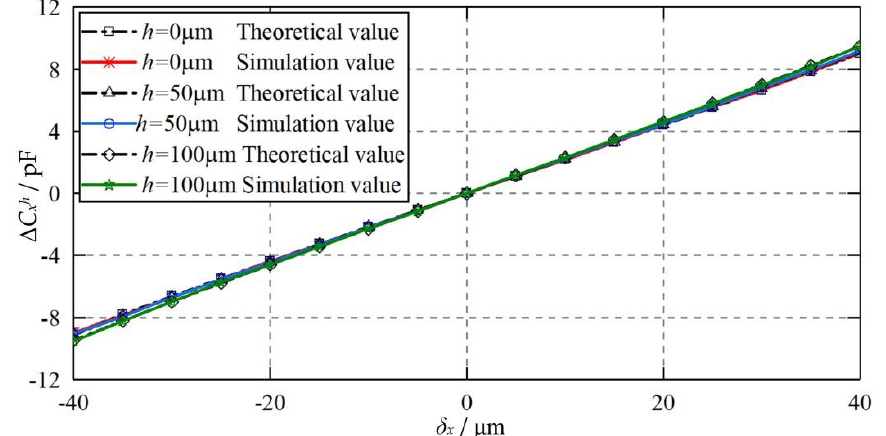
Figure 15. Dependence of the differential capacitance Δ C xh on the eccentric displacement of the ball when CP S1 and CP S3 are radial offset and misaligned with each other.